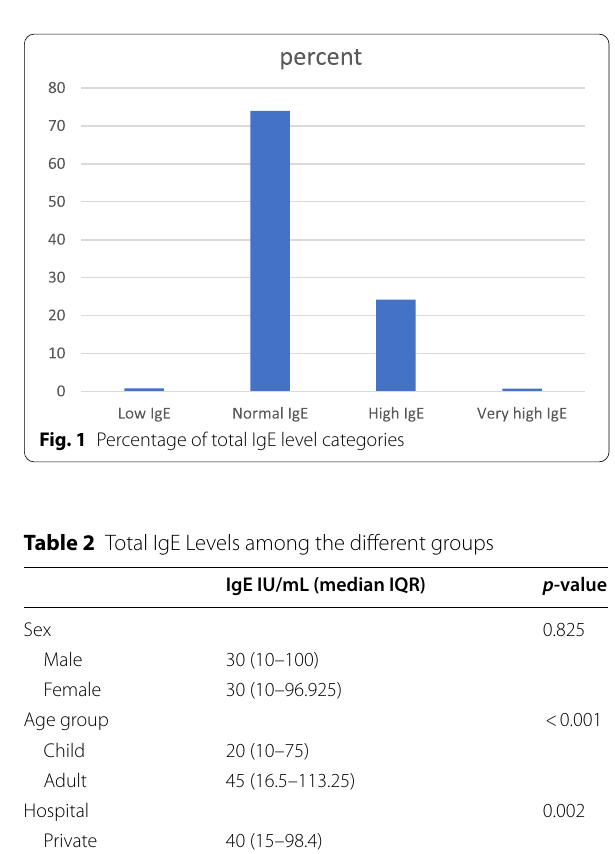
Data presented as median, (IQR) interquartile range; significant p -value < 0.05